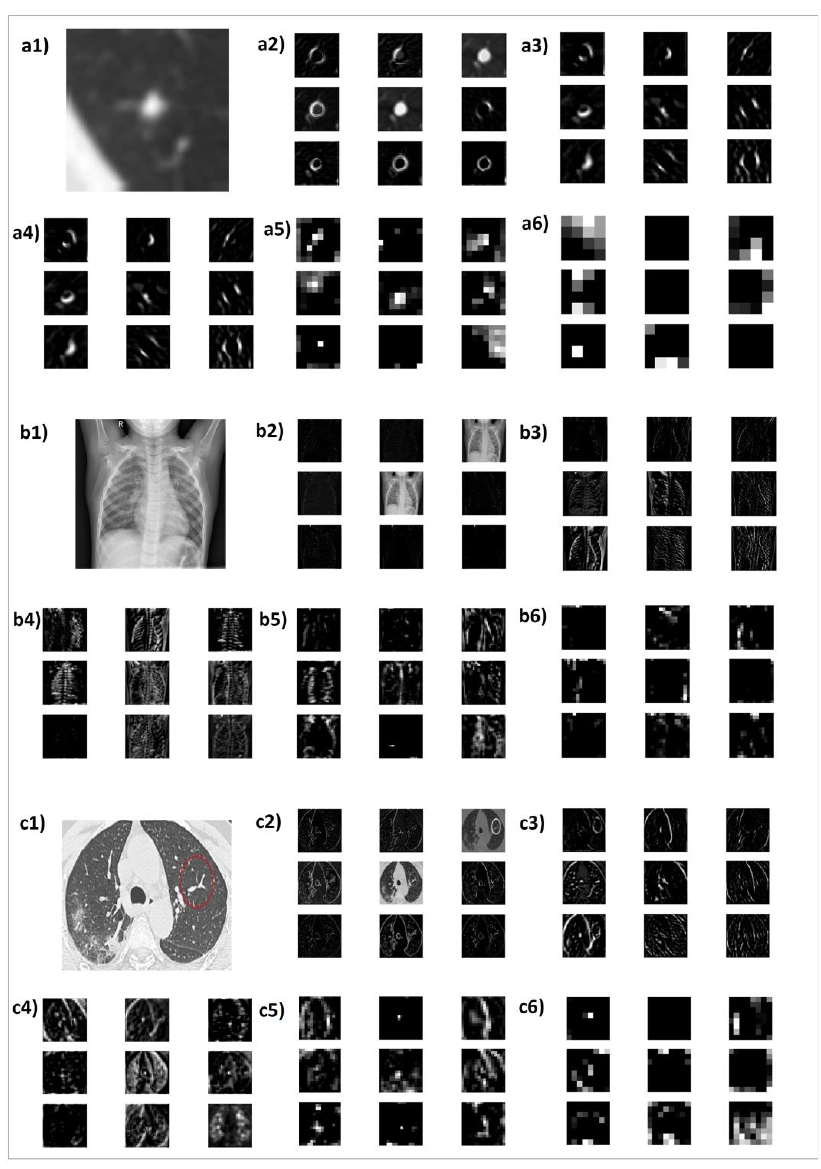
Figure 5. FF-VGG19 extracted feature maps of a random input image, where ( a1 – a6 ) refer to feature maps from the LIDC-IDRI + PET dataset, ( b1 – b6 ) refer to features maps from the COV_X dataset, and ( c1 – c6 ) refer to the COV_CT dataset.